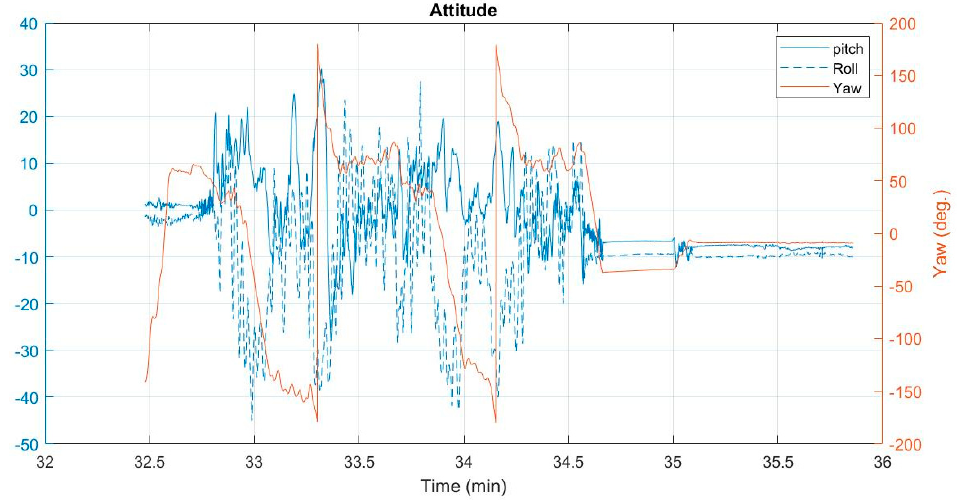
Figure 18. Attitude in the second round of the second flight test (time = 32–36 s).